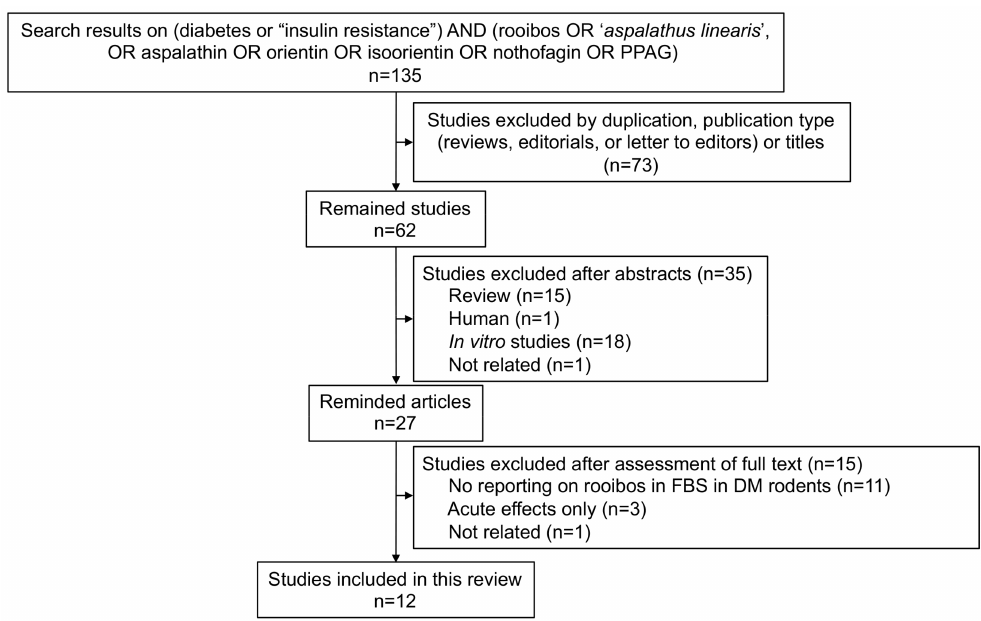
Figure 1. Flow diagram of literature search and selection process.